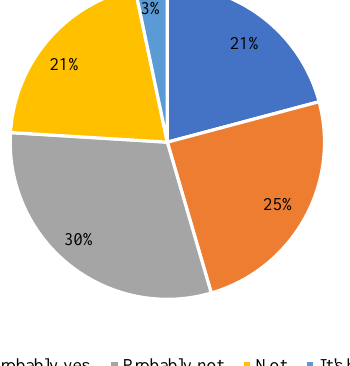
Figure 4. Characteristics of the respondents in terms of the use of a mobile phone while walking on the street or on the sidewalk.